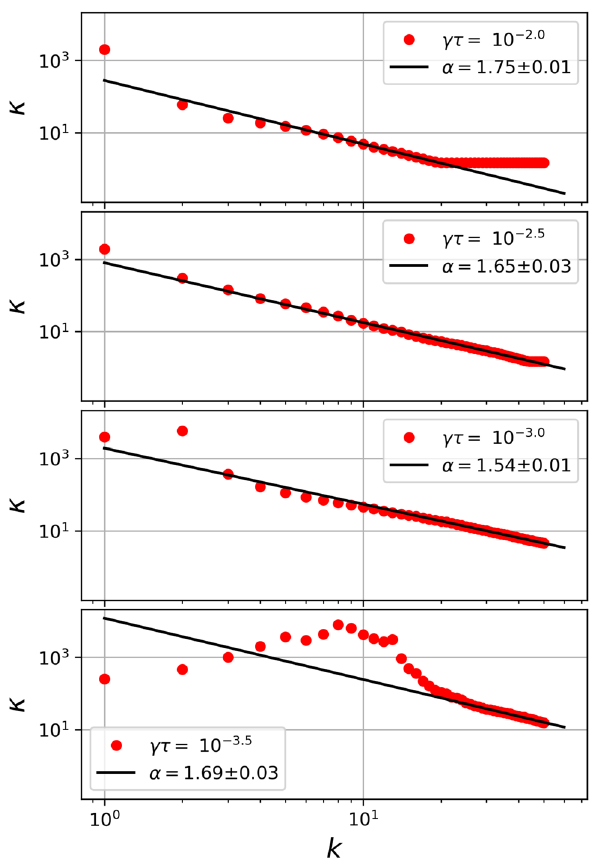
2.0 2.5 3.0 3.5 , 10 − , 10 − , and 10 − ). For